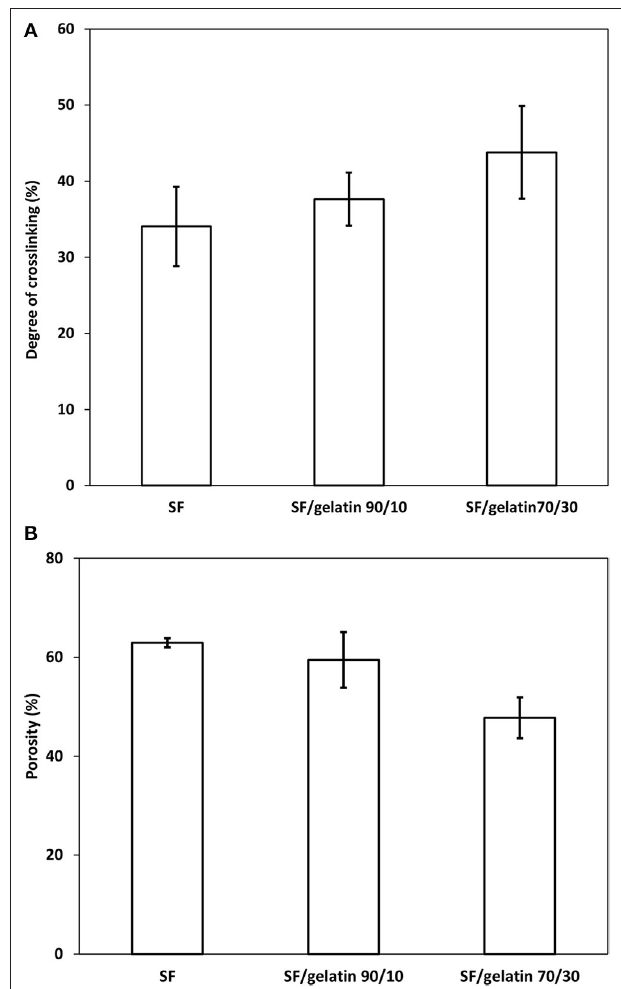
FIGURE 6 | (A) Degree of crosslinking and (B) porosity of GTA crosslinked SF nanofiber mats and SF/gelatin nanofiber